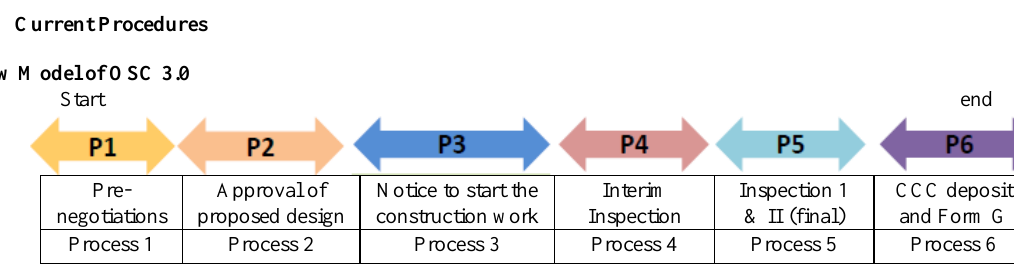
Figure 6: New OSC model (3.0) for planning